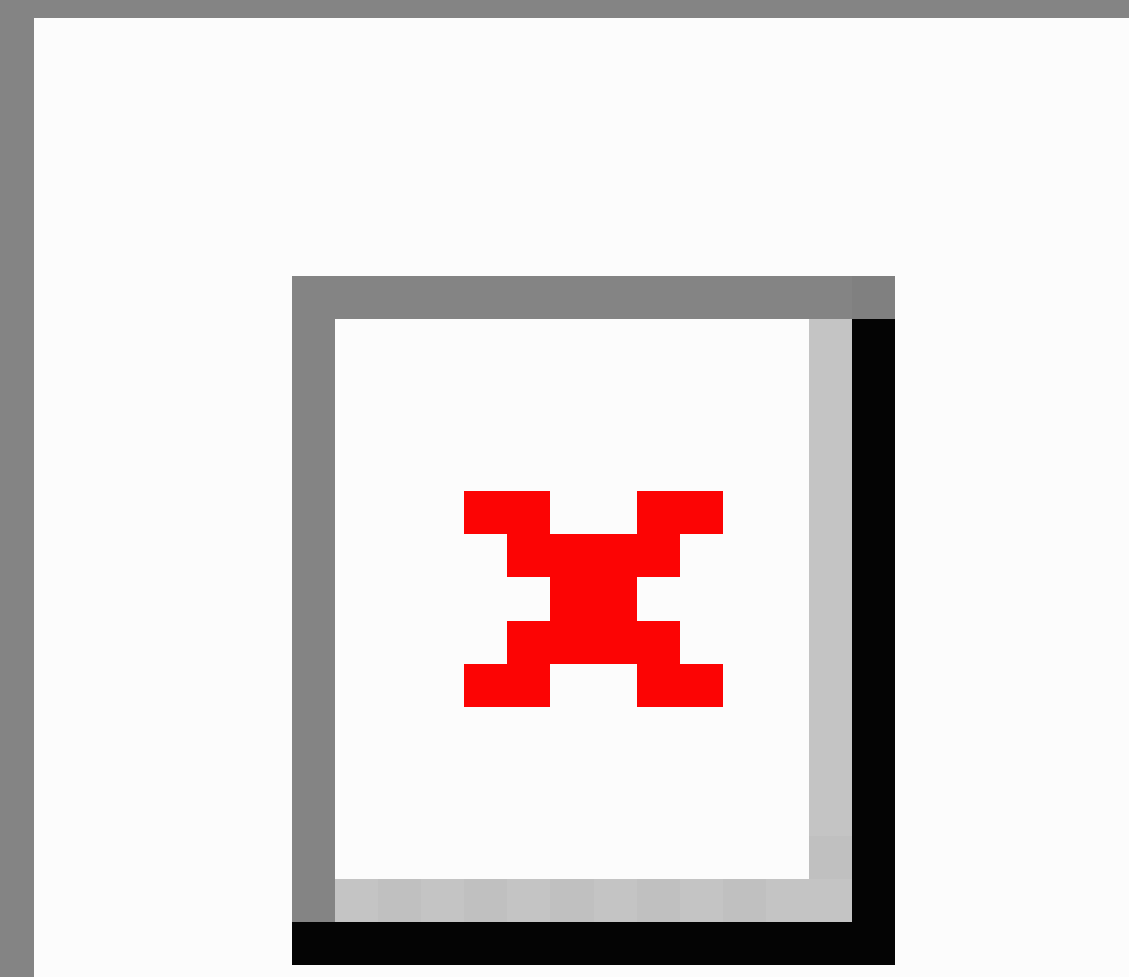
Figure 4. Learning curve analysis. (A) No undersampling. (B) Sampling ratio of 1:2. (C) Sampling ratio of 1:4. (D) Sampling ratio of 1:8. The top row shows the association between accuracy and number of epochs, and the bottom row shows the association between cross-entropy loss and number of epochs; the blue and orange lines show the results of training and validation,